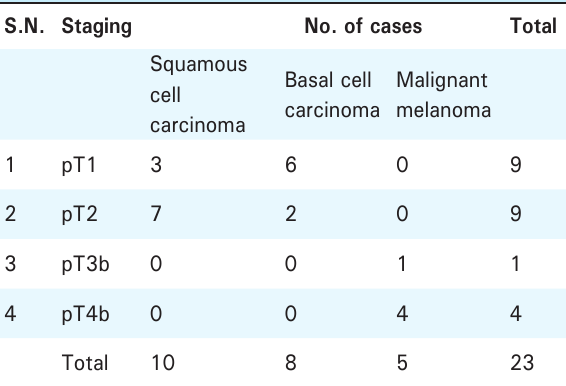
Table 4. Histological staging of malignant tumors as per TNM